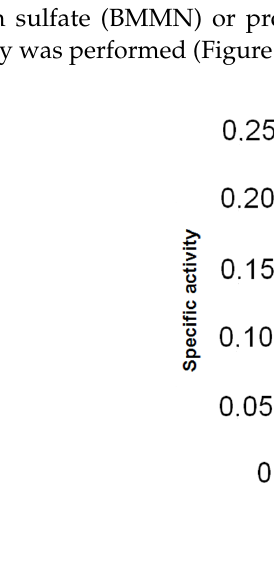
Figure 4. The effect of proline on the mitochondrial activity in the cells of K. phaffii X-33 strain: ( a ) image of the MTT assay results; ( b ) bar chart representation of mitochondrial activity in the cultures of X-33 strain after growth and methanol induction in media with ammonium sulphate or proline. The mean with SEM from four separate experiments with two technical replications is presented (* p < 0.01; Mann–Whitney U test).